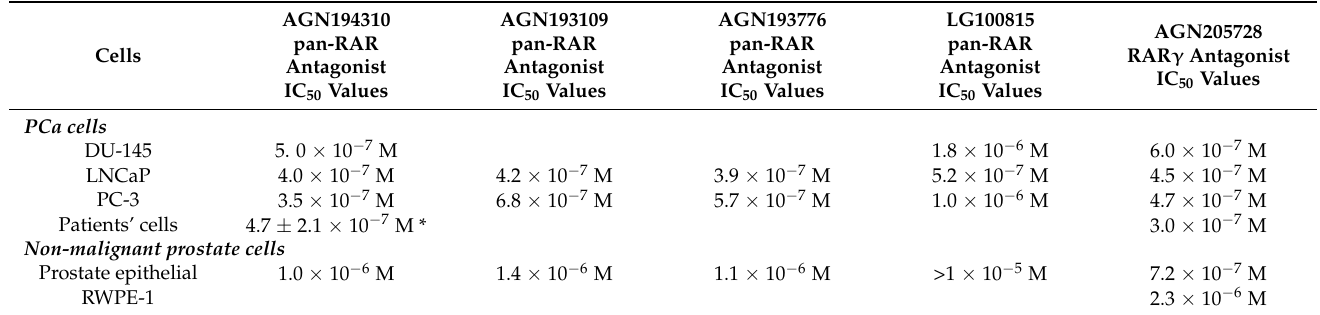
Table 2. Pan-RAR and RAR γ antagonists are potent inhibitors of the growth of flask cultures of PCa cells * mean of the IC 50 values obtained for the AGN194310 pan-RAR antagonist when tested against primary cells from 14